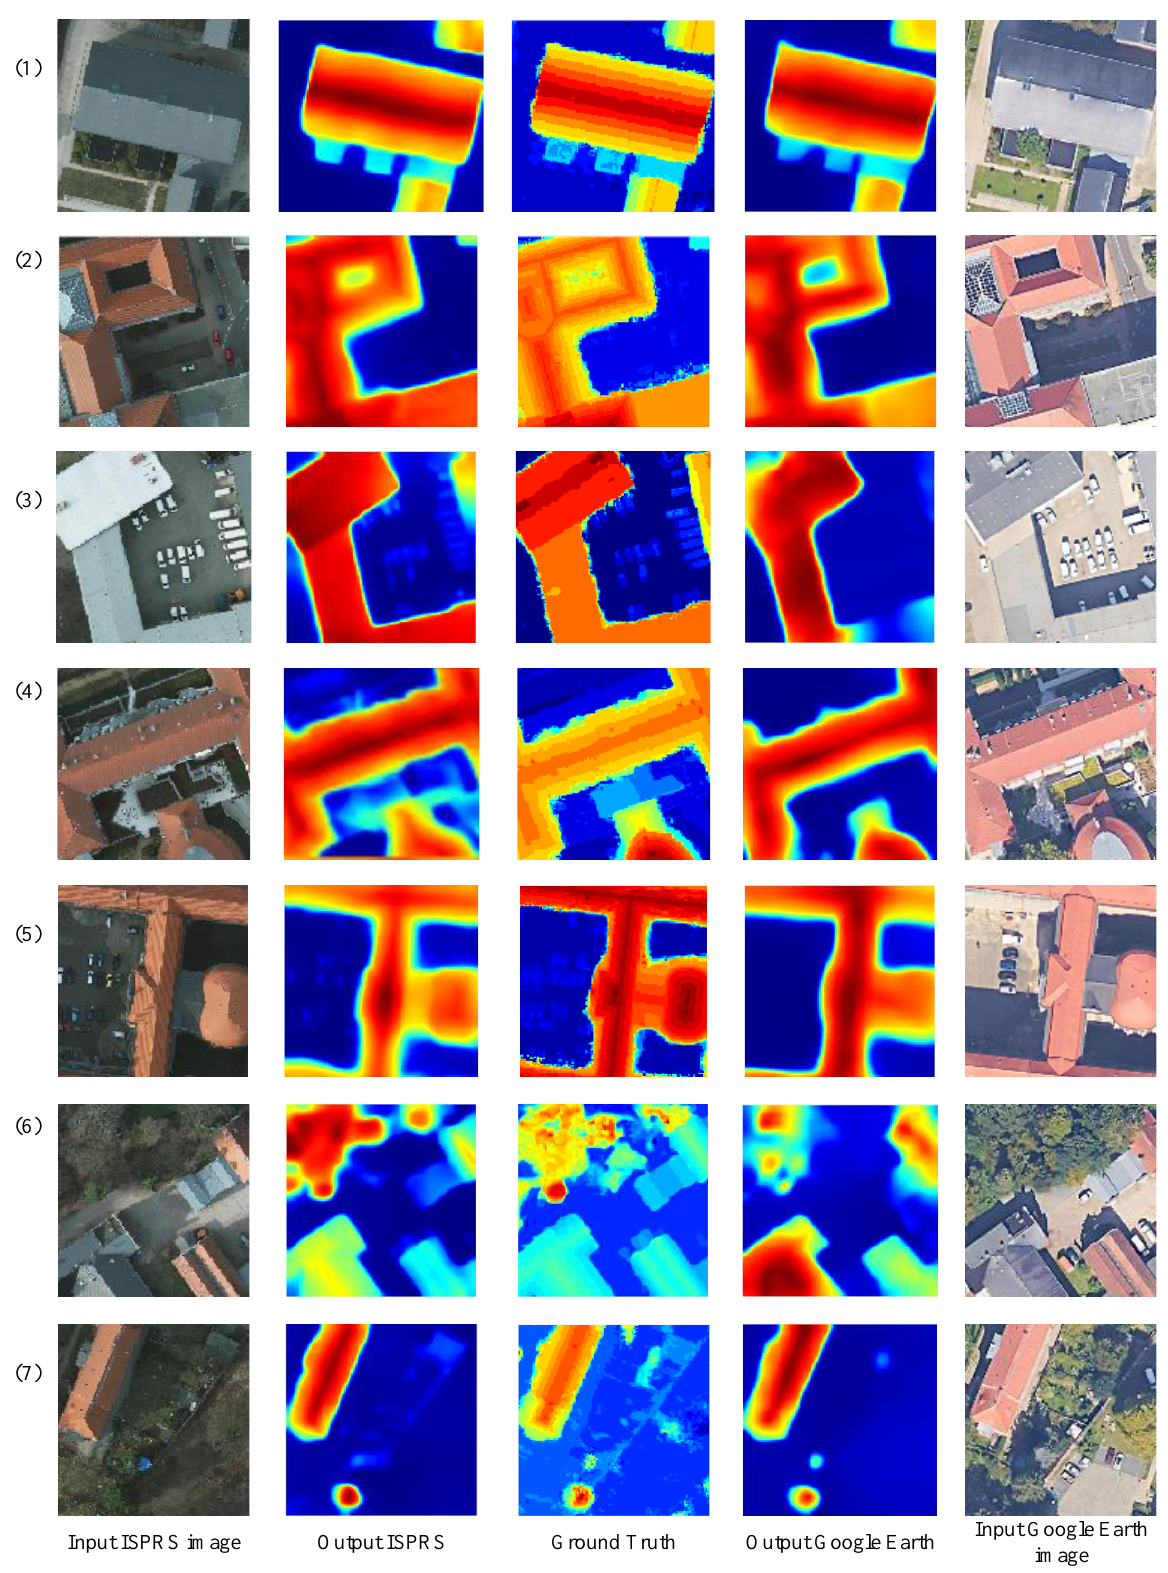
Figure 3. Qualitative comparison of the deep models on the ISPRS Potsdam